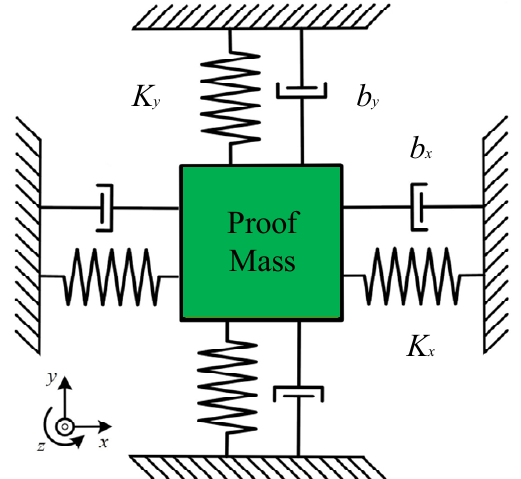
Figure 1. Mechanical model of MEMS gyroscope. For the gyroscope driving mode, the sum of the external forces on the mass in the x -axis direction is equal to the product of acceleration and mass. According to Equation (1), the acceleration of the proof mass in the driving direction of the gyro system can be obtained, and the external force of the proof mass in the x -axis direction can be obtained, including the driving force, spring elastic force and damping force.